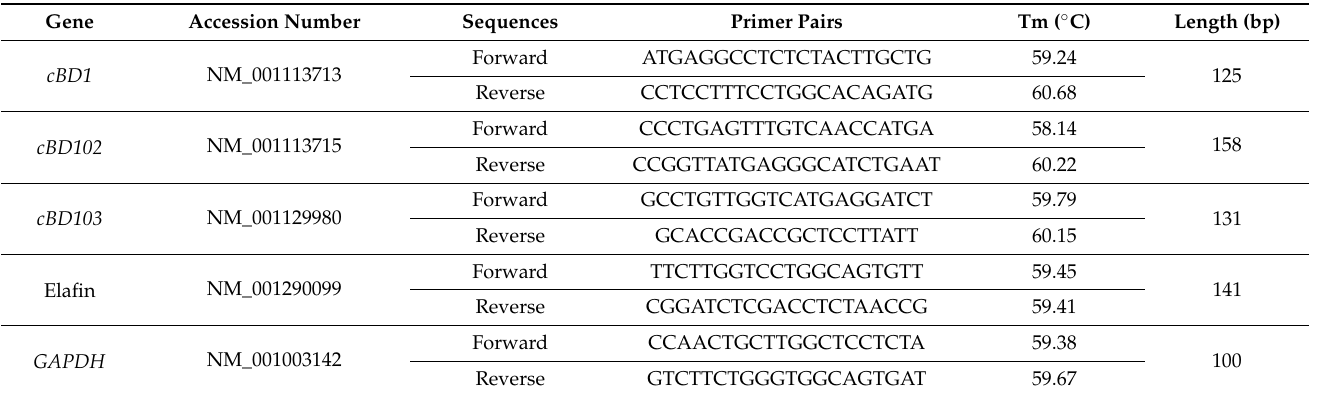
Table 1. Primer sequences for RT-qPCR.